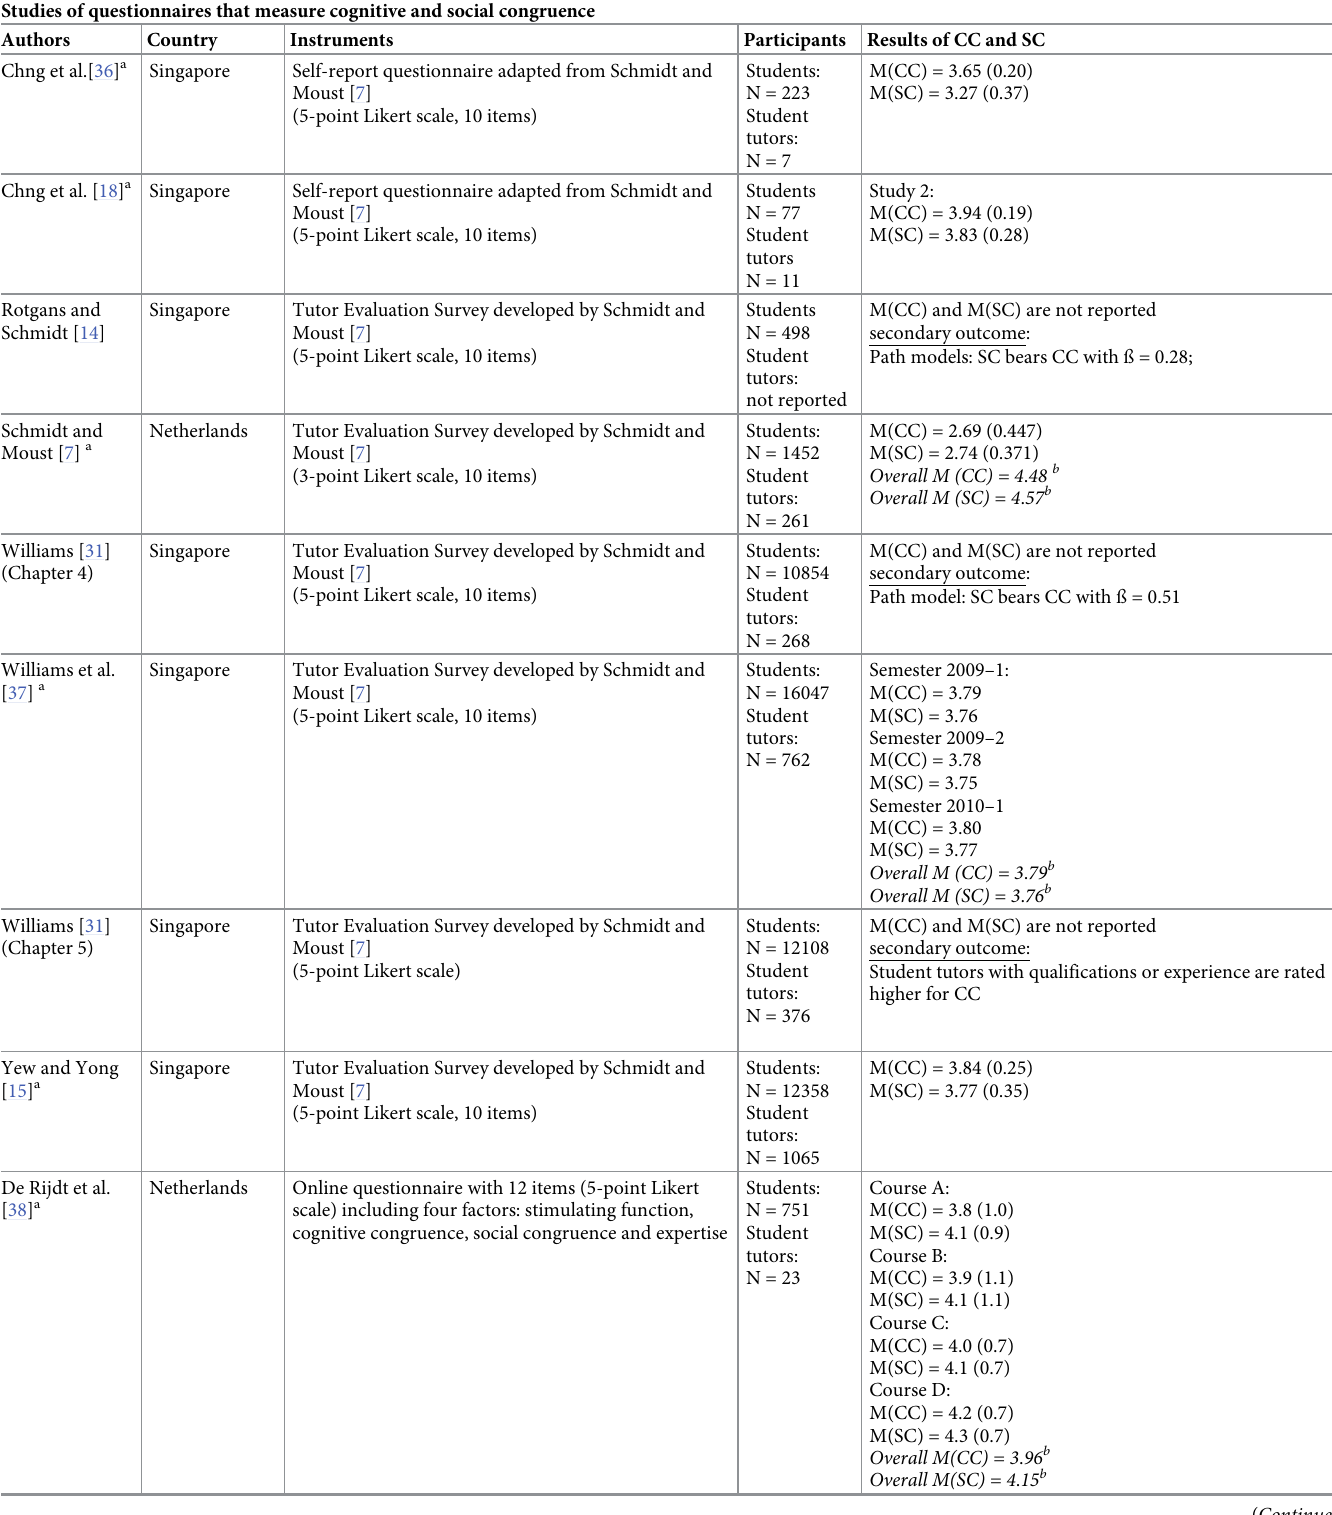
Table 1. Overview of studies investigating cognitive (CC) and social congruence (SC). Studies of questionnaires that measure cognitive and social